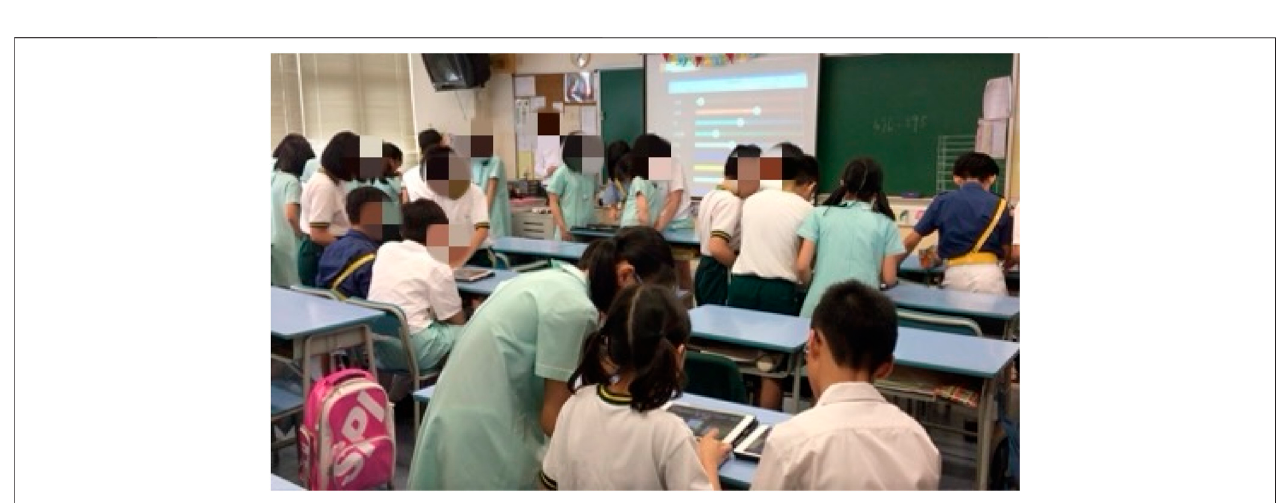
FIGURE 4 | Students work in group to compete using Quizlet, with the classroom projector showing each group ’ s